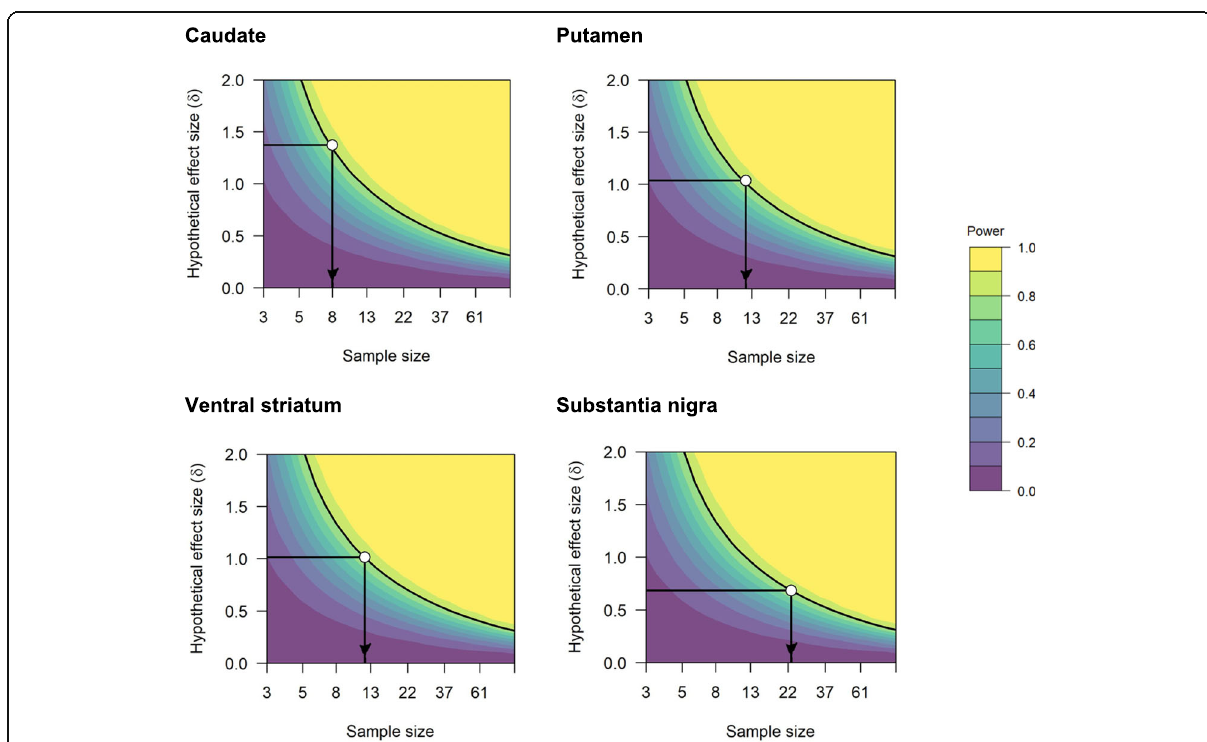
Fig. 4 Relationship between sample size and effect size for caudate, putamen, ventral striatum, and substantia nigra. The arrow indicates the sample size needed to detect a statistically significant difference with 0.8 power, based on the effect size corresponding to a 10%